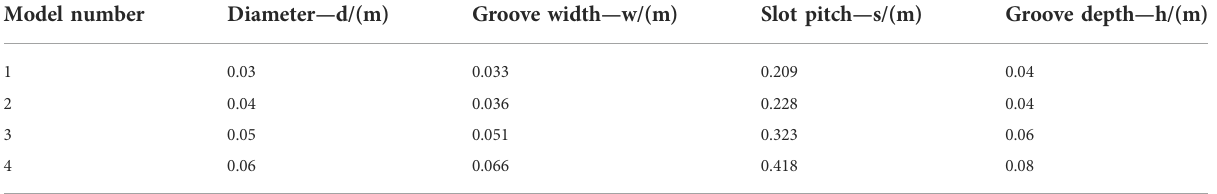
TABLE 2 Four peak rate of fl uid resistance reduction